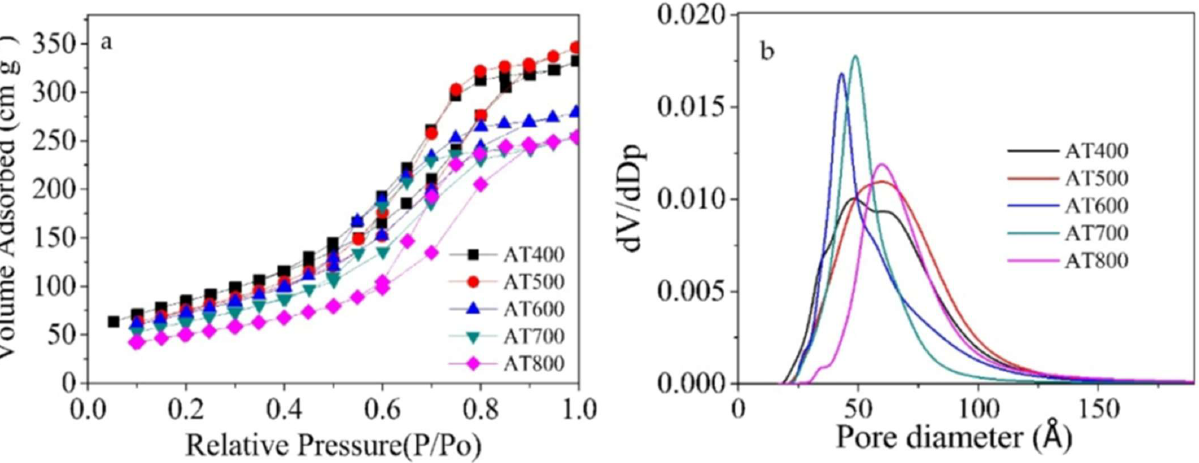
Figure 2. ( a ) Nitrogen adsorption−desorption isotherms and ( b ) pore diameter of materials of AT series calcined at different temperatures.